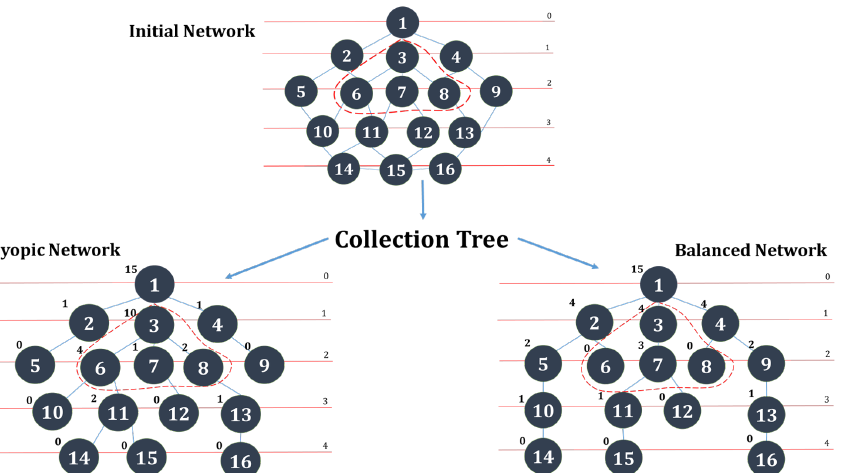
Figure 1. Relevance of efficient Cyber-Physical Systems-Internet-of-Things (CPS-IoT)